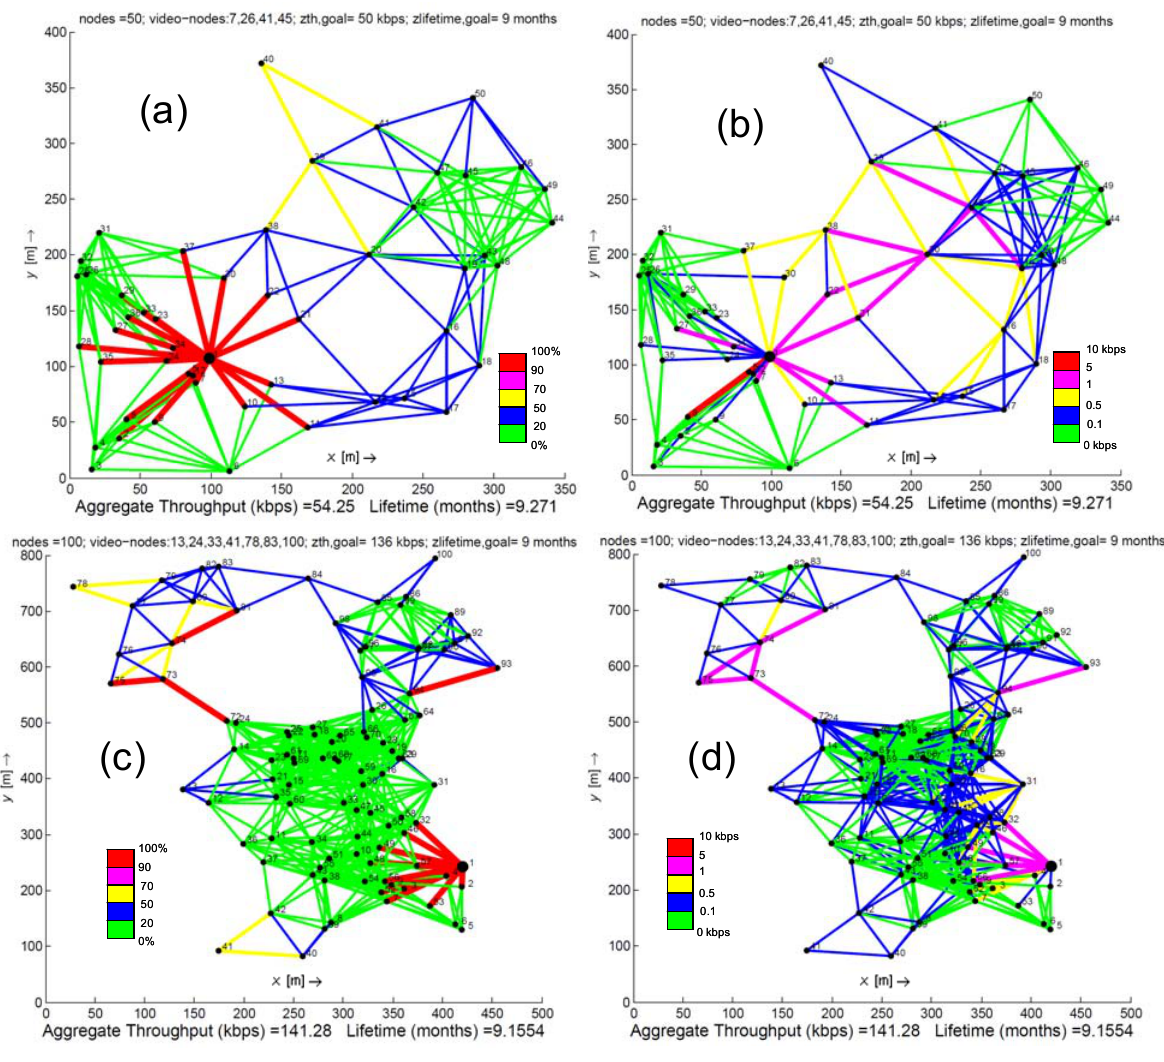
Figure 2. Results obtained for two random topologies of 50 and 100 nodes, respectively. Figures 2( a ) and 2( c ) present the % traffic load distributed by each node. Figures 2( b ) and 2( d ) plot the achieved throughput per link